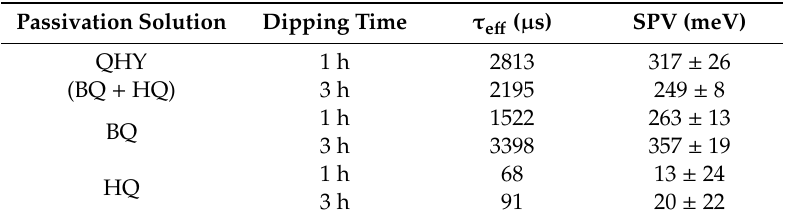
Table 1. SPV values measured by Kelvin Probe system compared with τ eff from different dipping times and passivation solutions.